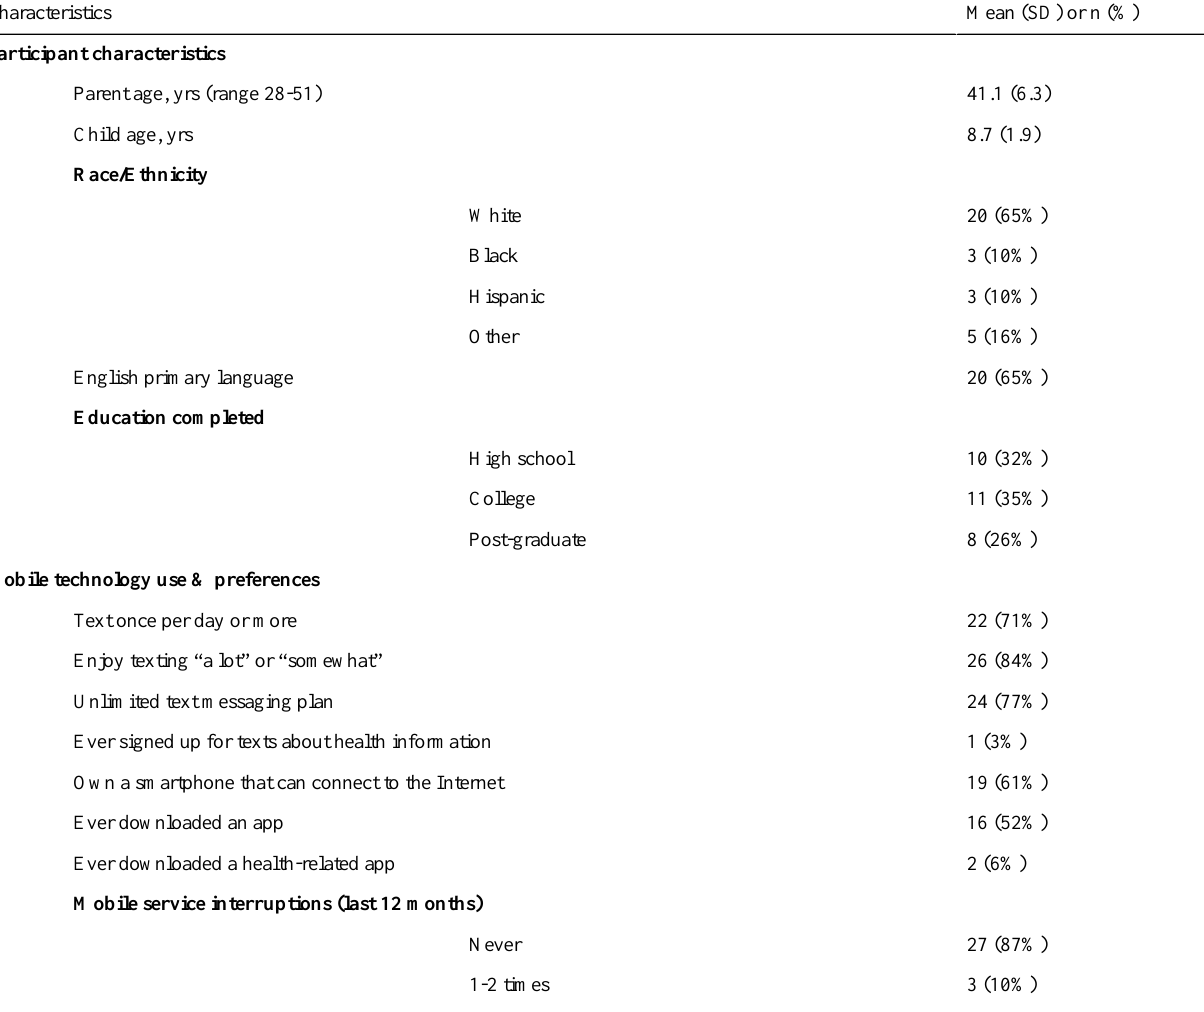
Table 1. Participant characteristics and mobile technology use and preferences among 31 participants in parent focus